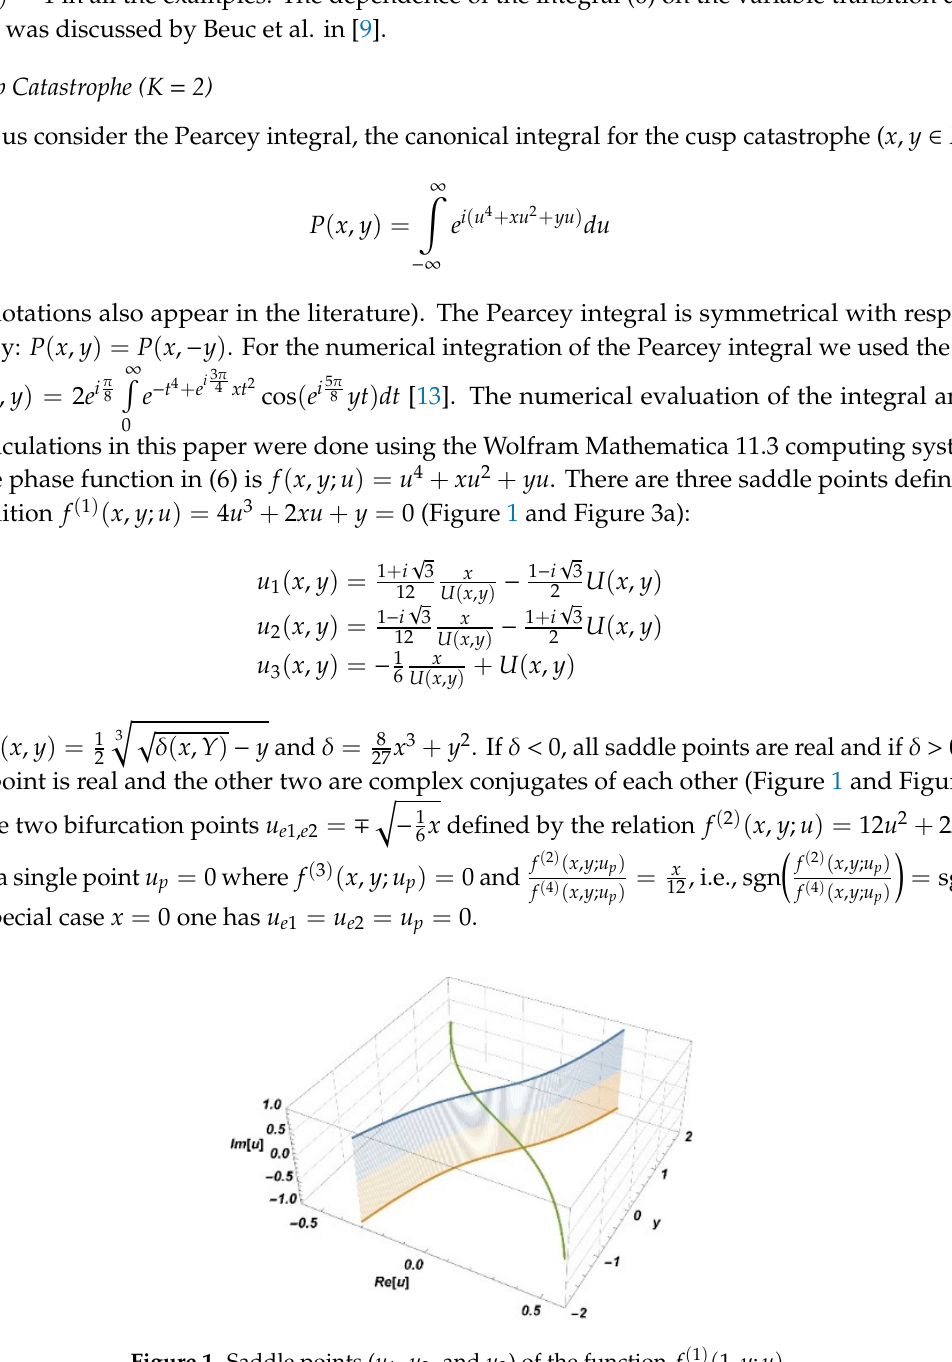
Figure 1. Saddle points ( 1